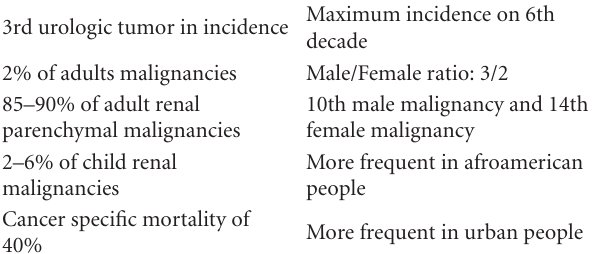
Table 1: Epidemiologic features of the RCC.